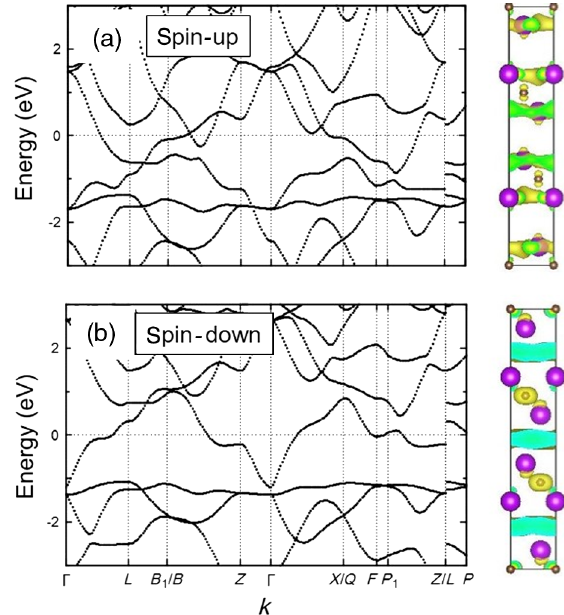
FIG. 5. Calculated energy band and PED isosurface plot for Gd 2 C corresponding to each spin channel ( U − J ¼ 6 eV, J ¼ 0 . 7 eV).